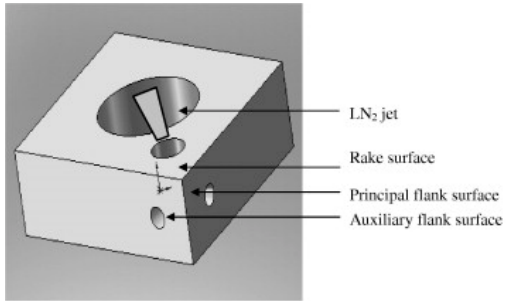
Figure 1. Modified cutting insert for cryogenic cooling method [30] .